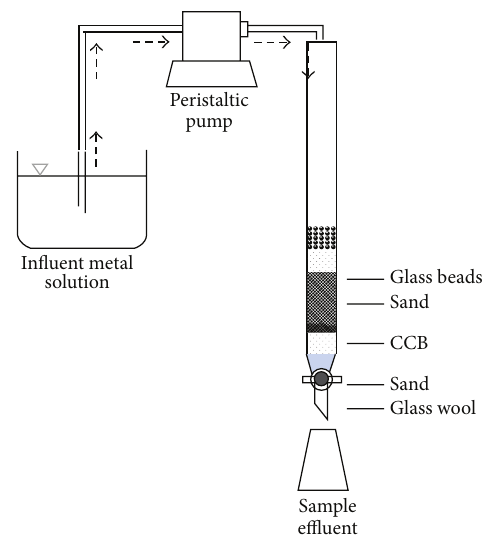
Figure 1: Fixed-bed adsorption set-up for multimetal adsorption unto